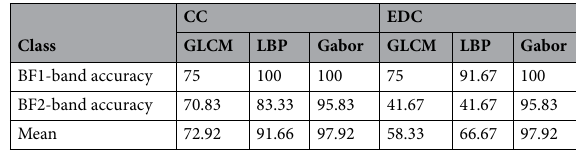
Table 4. Classification accuracy of the new